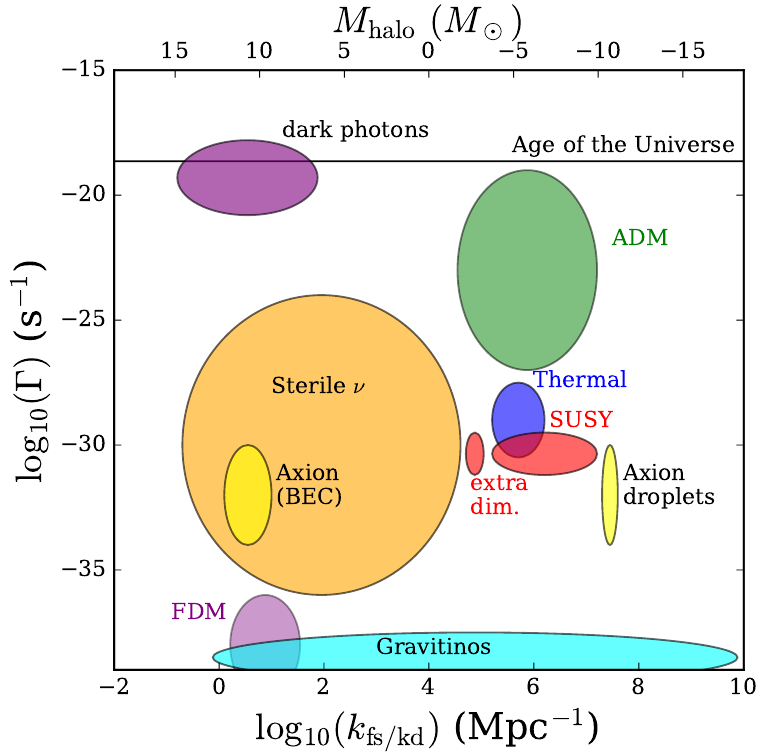
Figure 15. Allowed parameter space of the currently most popular dark-matter candidates. The bottom axis shows the characteristic free-streaming wavenumber of the model, which is set in the primordial Universe. The top axis shows the corresponding halo mass, and the y-axis shows the characteristic interaction or decay rate which quantifies the evolutionary effects of dark matter. ADM, BEC, and FDM stand for Asymmetric Dark Matter, Bose-Einstein Condensate, and Fuzzy Dark Matter, respectively. The figure is from